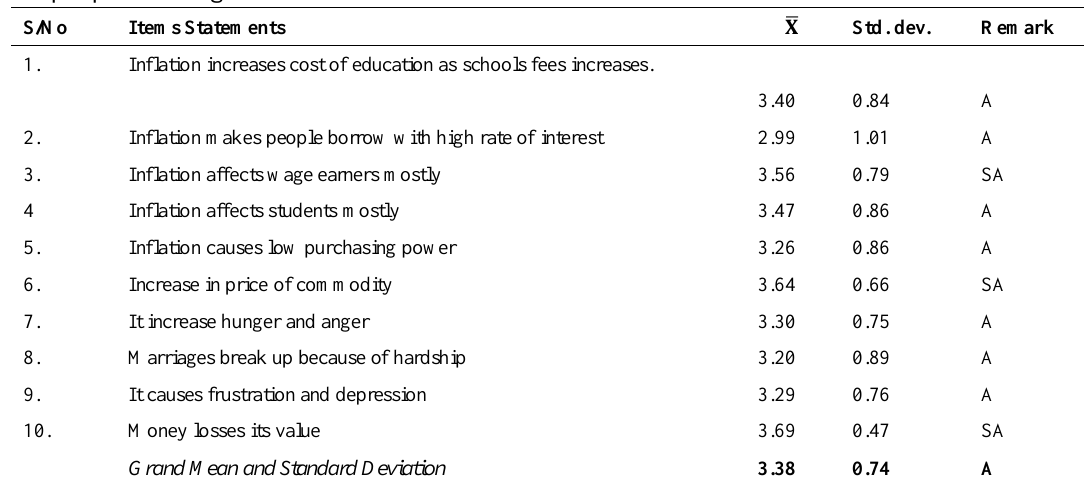
Table 4: Mean and Standard deviation of responses of respondents on the consequences of inflation on the people of Enugu state